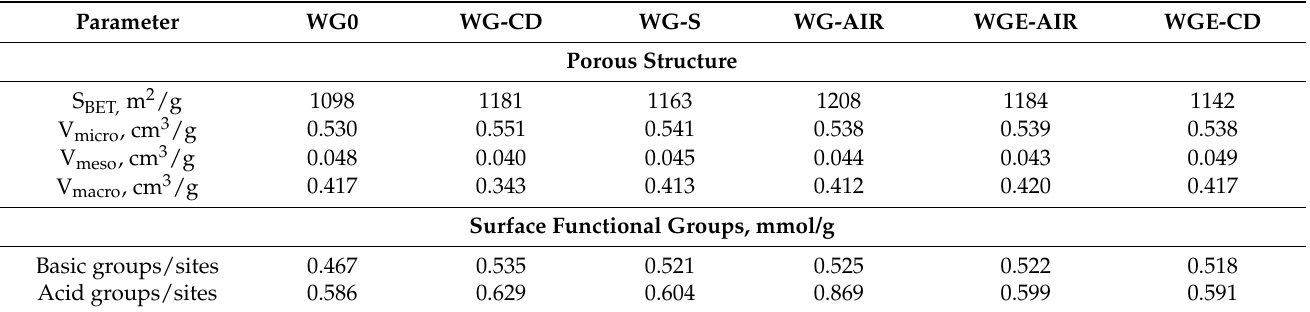
Table 10. Characteristics of modified activated carbons.